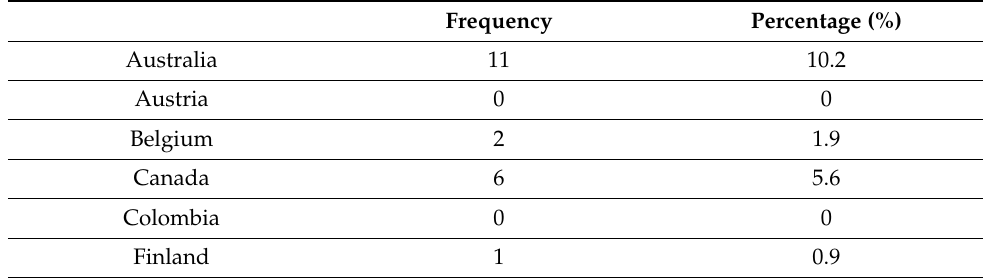
Table A8. Frequency and percentage of diplomates per